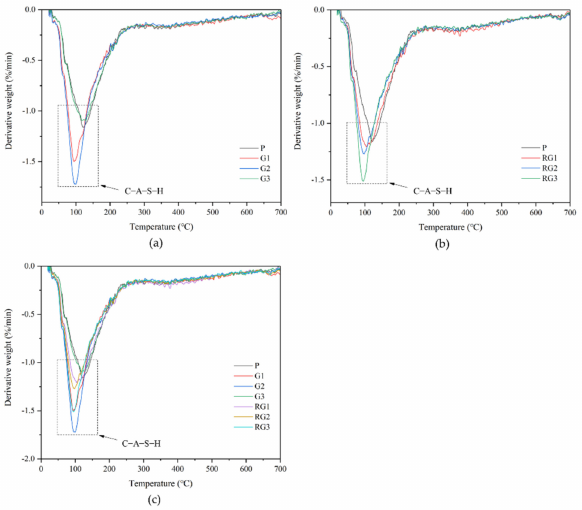
Figure 12. TGA results of the samples: ( a ) with GO addition; ( b ) with rGO addition; ( c ) with GO/rGO